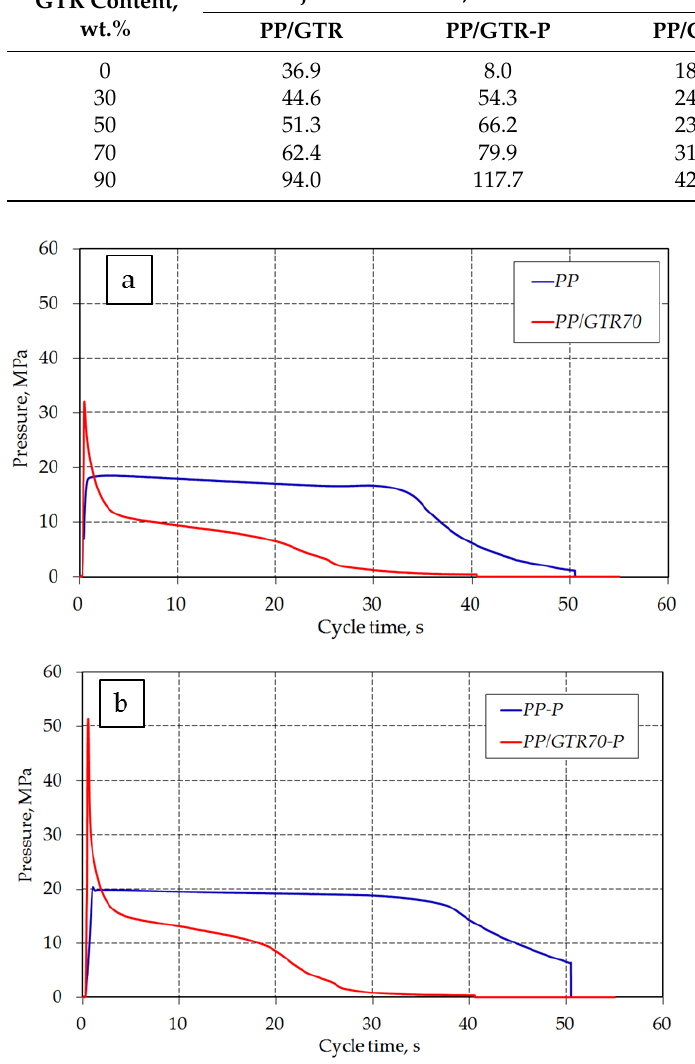
Figure 8. Pressure curves in the mold cavity for pure polypropylene and polypropylene filled with 70% GTR: ( a ) without DHBP, ( b ) addition of 1.5% DHBP. Table 3. Values of injection pressure and pressure in the mold cavity during filling phase .